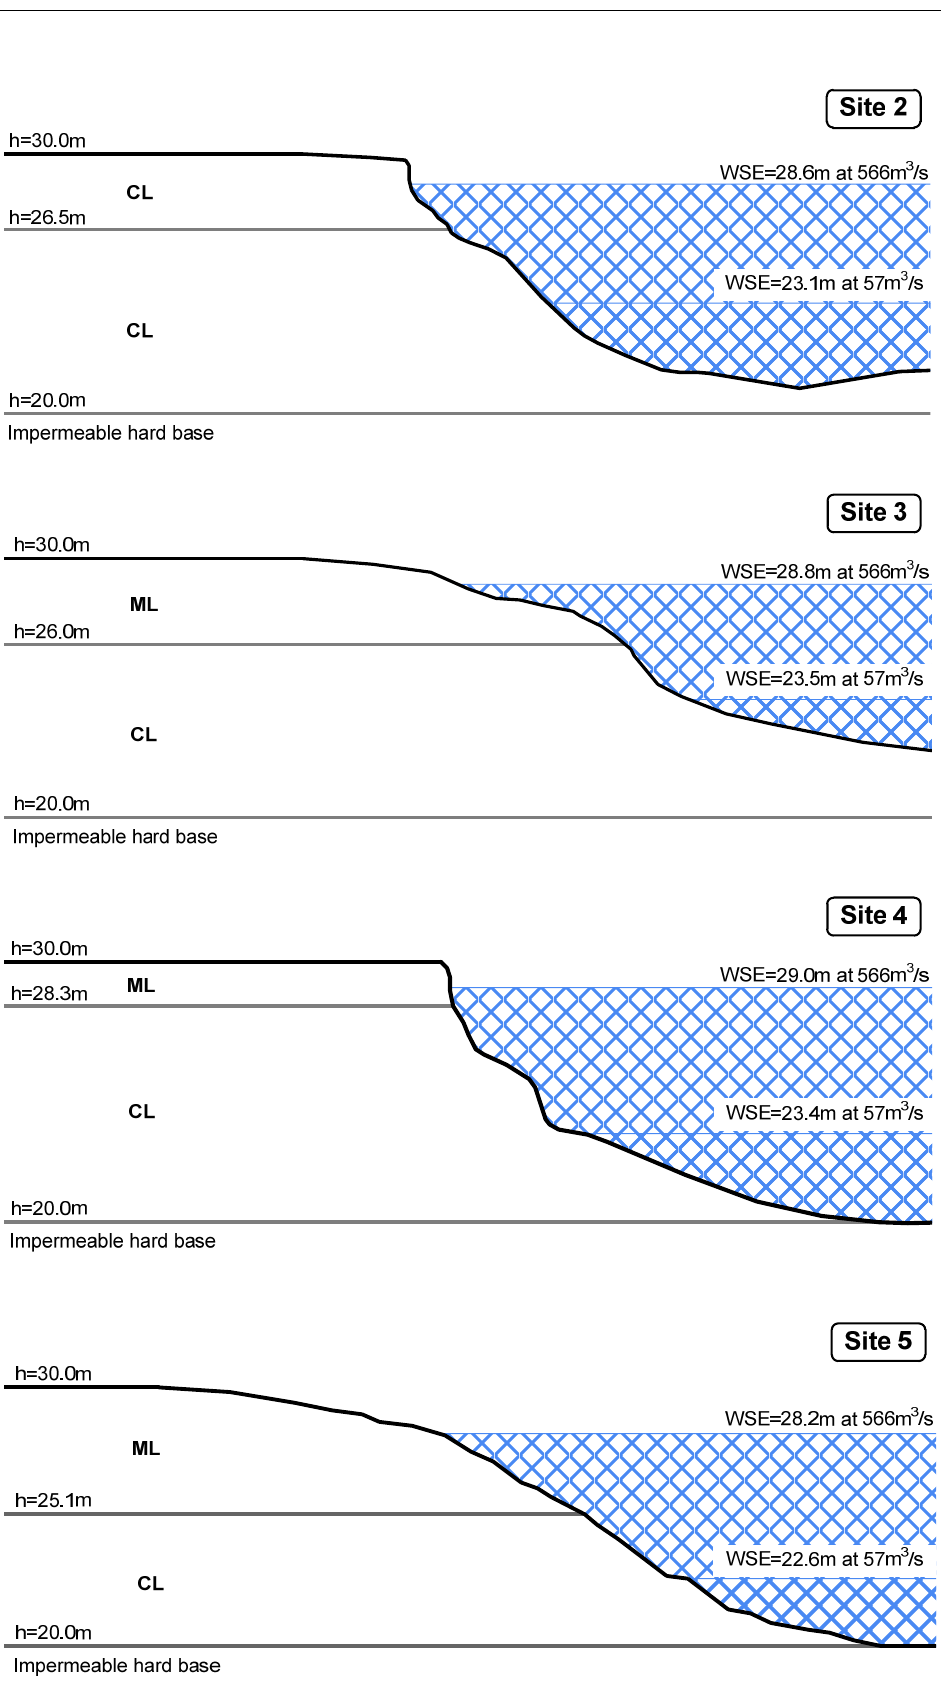
Figure 4. Riverbank cross-section and profile with water surface elevation (WSE) locations.